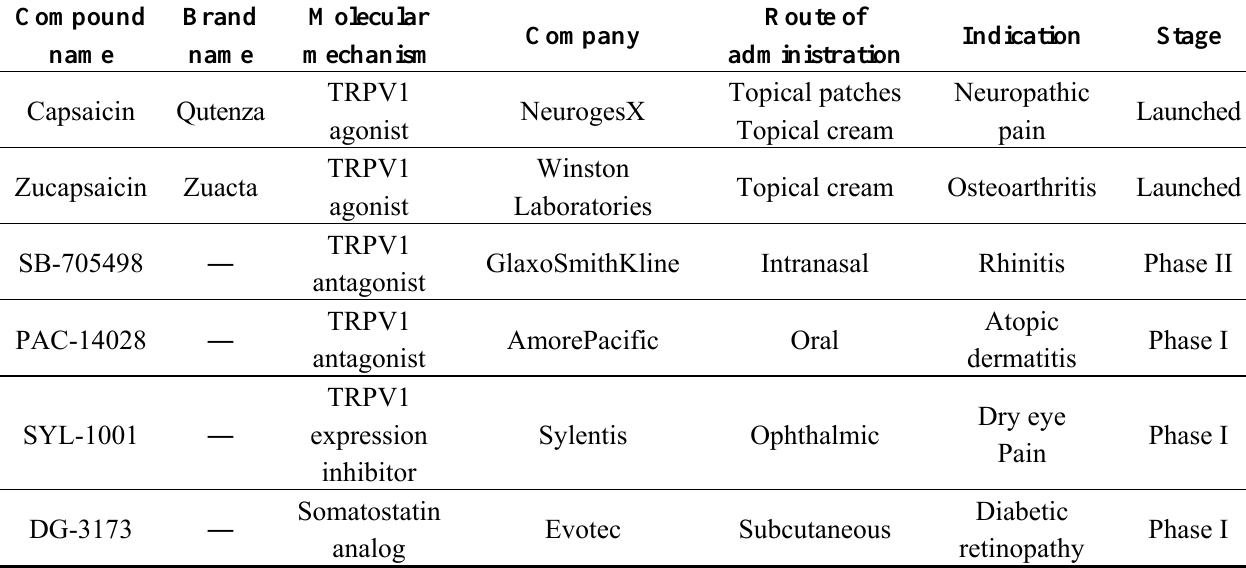
Table 1. Current clinical trial status of TRPV1 and somatostatin modulators developed by different drug discovery